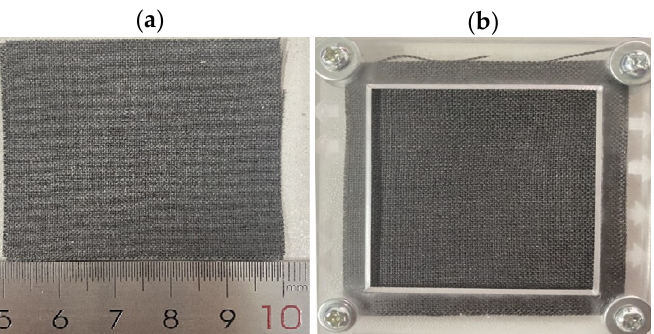
Figure 2. Sample drawing, where ( a ) is the carbon cloth after the hydrophilic treatment, and the hollowed-out part of ( b ) is the hydrophobic spraying